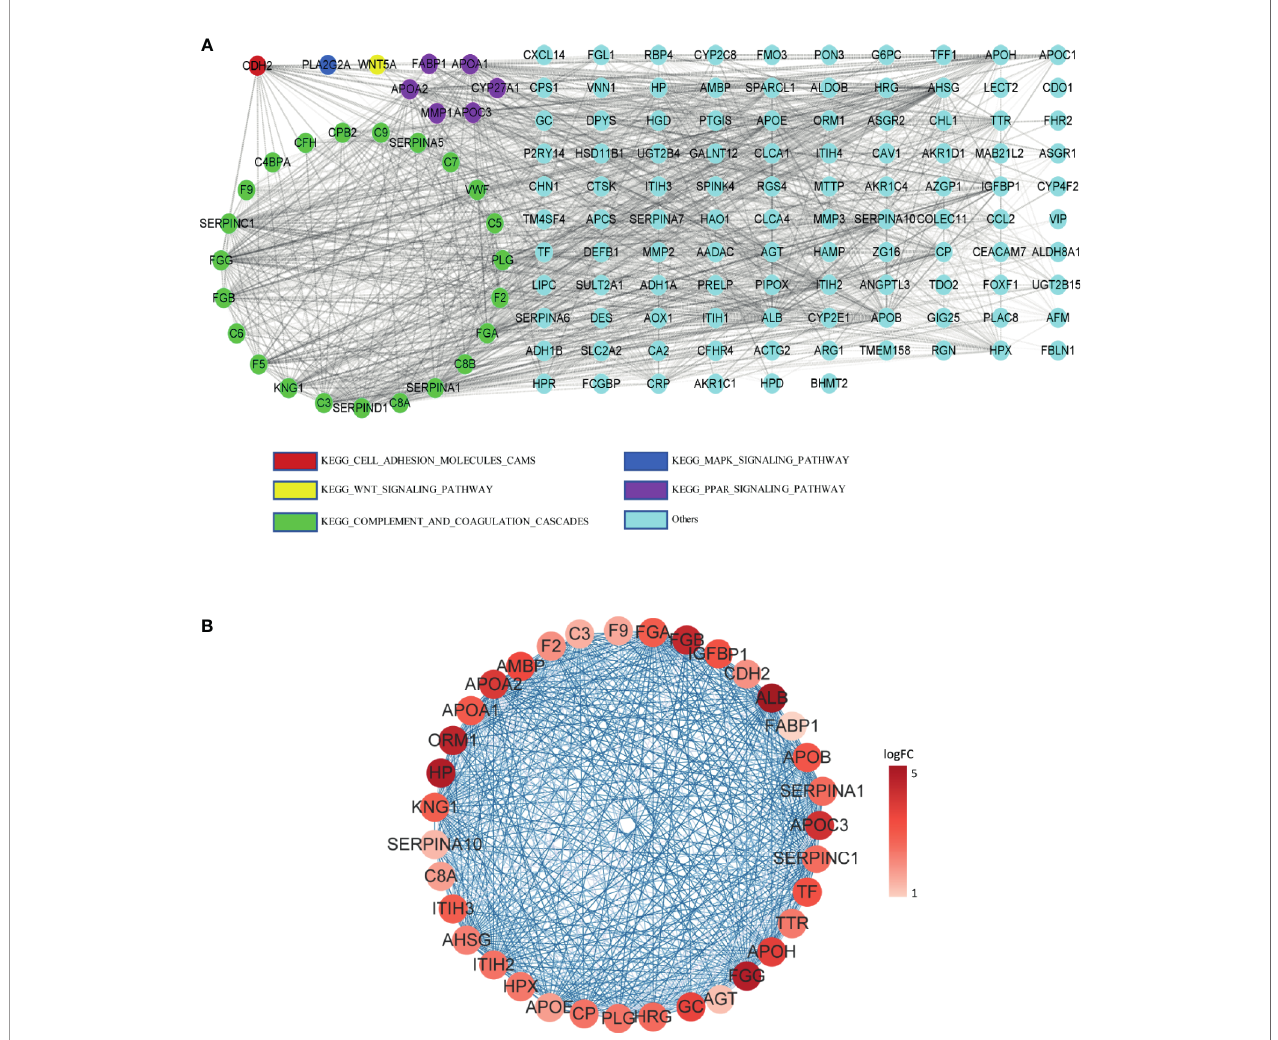
FIGURE 4 | PPI network among DEGs. (A) PPI network constructed by STRING; DEGs involving in KEGG pathway were represented by different colors. (B) Candidate hub genes with interactions visualized in Cytoscape; from pale red to dark red, the log2FC value of the gene in the sample gradually increases. Edge between two nodes indicates